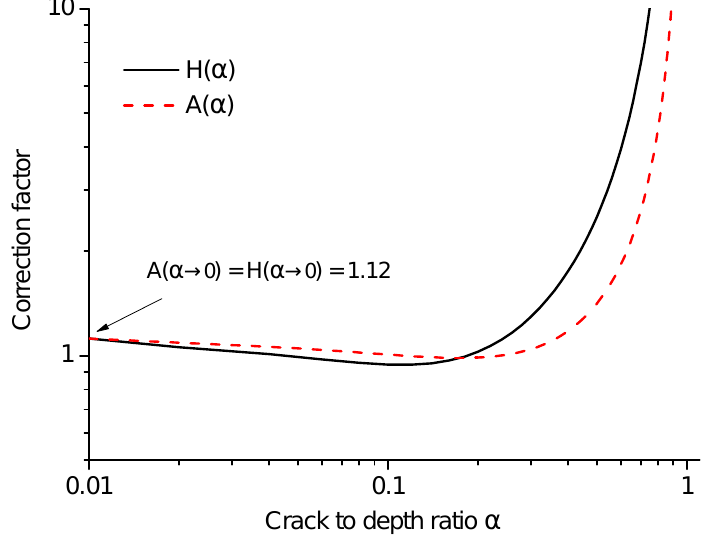
Figure 4. Correction factors A ( α ) and H ( α ) versus the crack to height ratio α